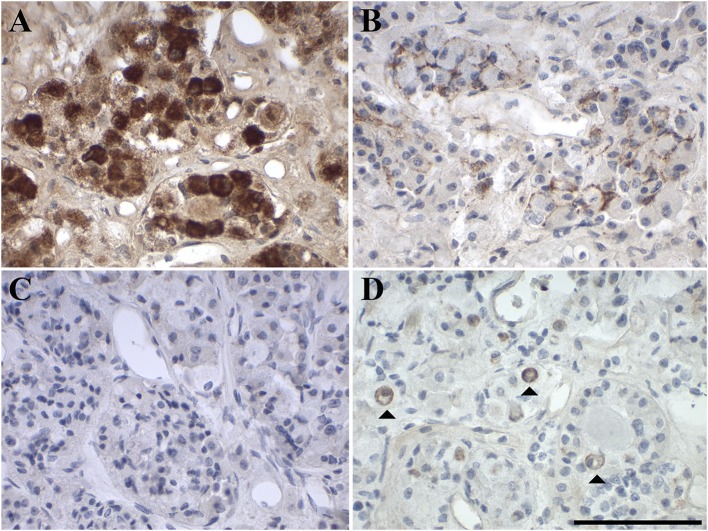
Representative images of immunohistochemical staining of (A) GAL, (B) GAL1-R, (C) GAL2-R, and (D) GAL3-R in human anterior pituitary gland (case 1). [scale bar: 100 μm].